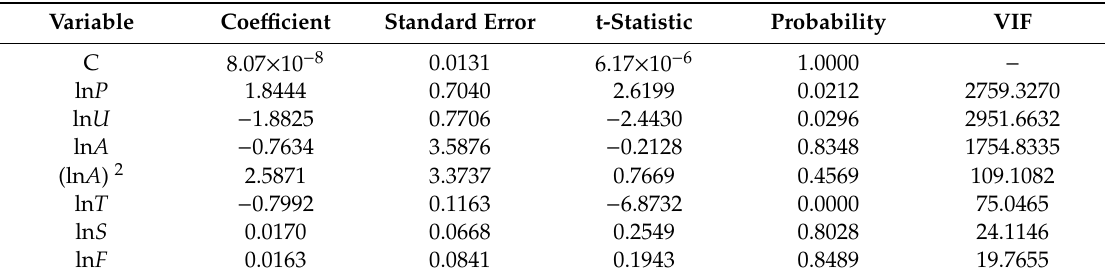
Table 4. Estimation of multivariate regression parameters.